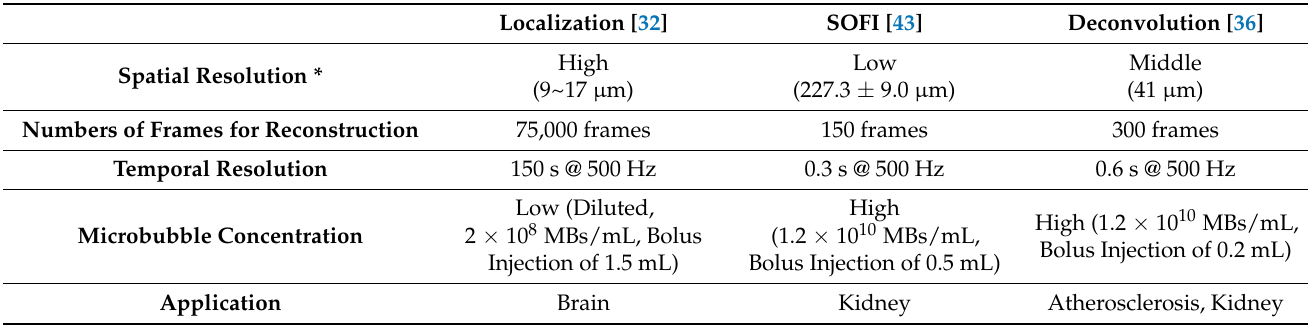
Table 1. The overall performances of the representative SRU imaging technologies. * All technologies offer spatial resolution beyond the acoustic diffraction limit. Localization [32] SOFI [43] Deconvolution